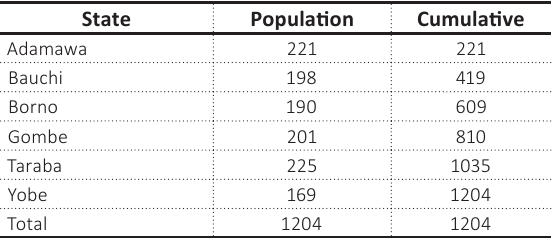
Table 1. The study population Source: Small and Medium Enterprise Development Agency,